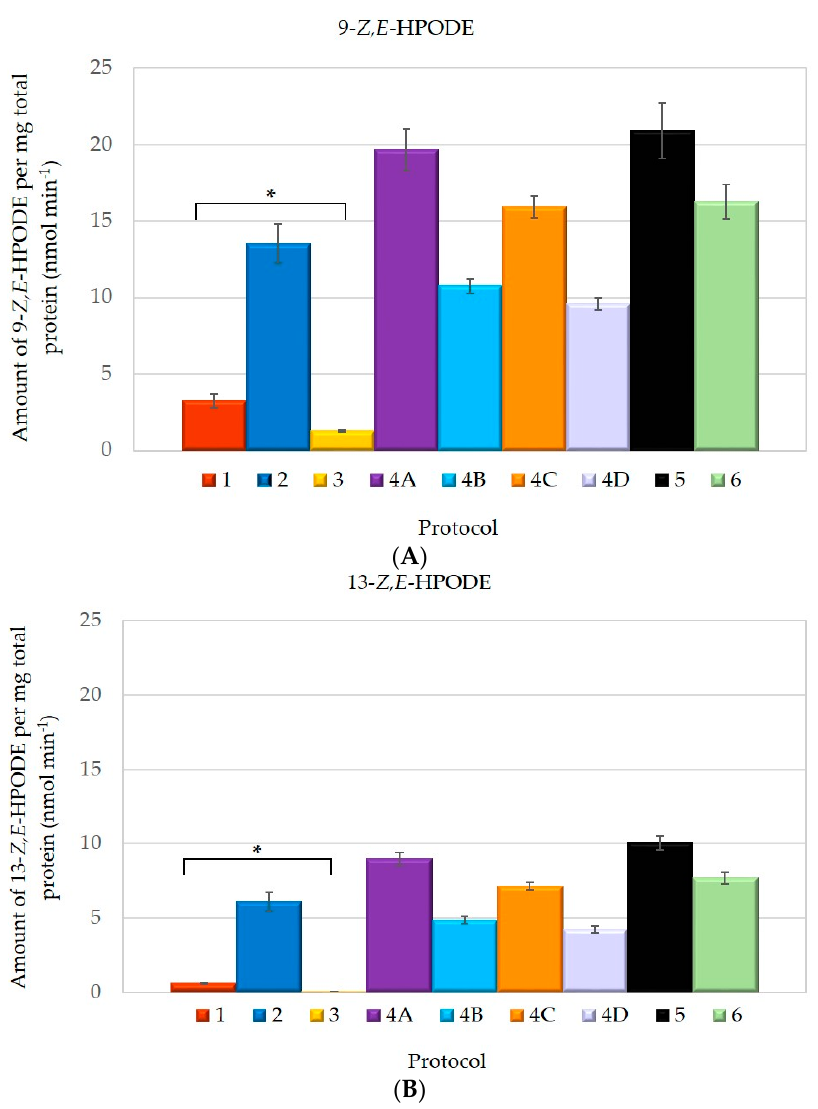
Figure 1. Lipoxygenase (LOX) activity calculated from the amount of: ( A ) 9- Z , E- HPODE and ( B ) 13- Z , E- HPODE, as determined by RP-HPLC with depicted bars representing * p << 0.05 (Anova, single factor and Scheffe test).